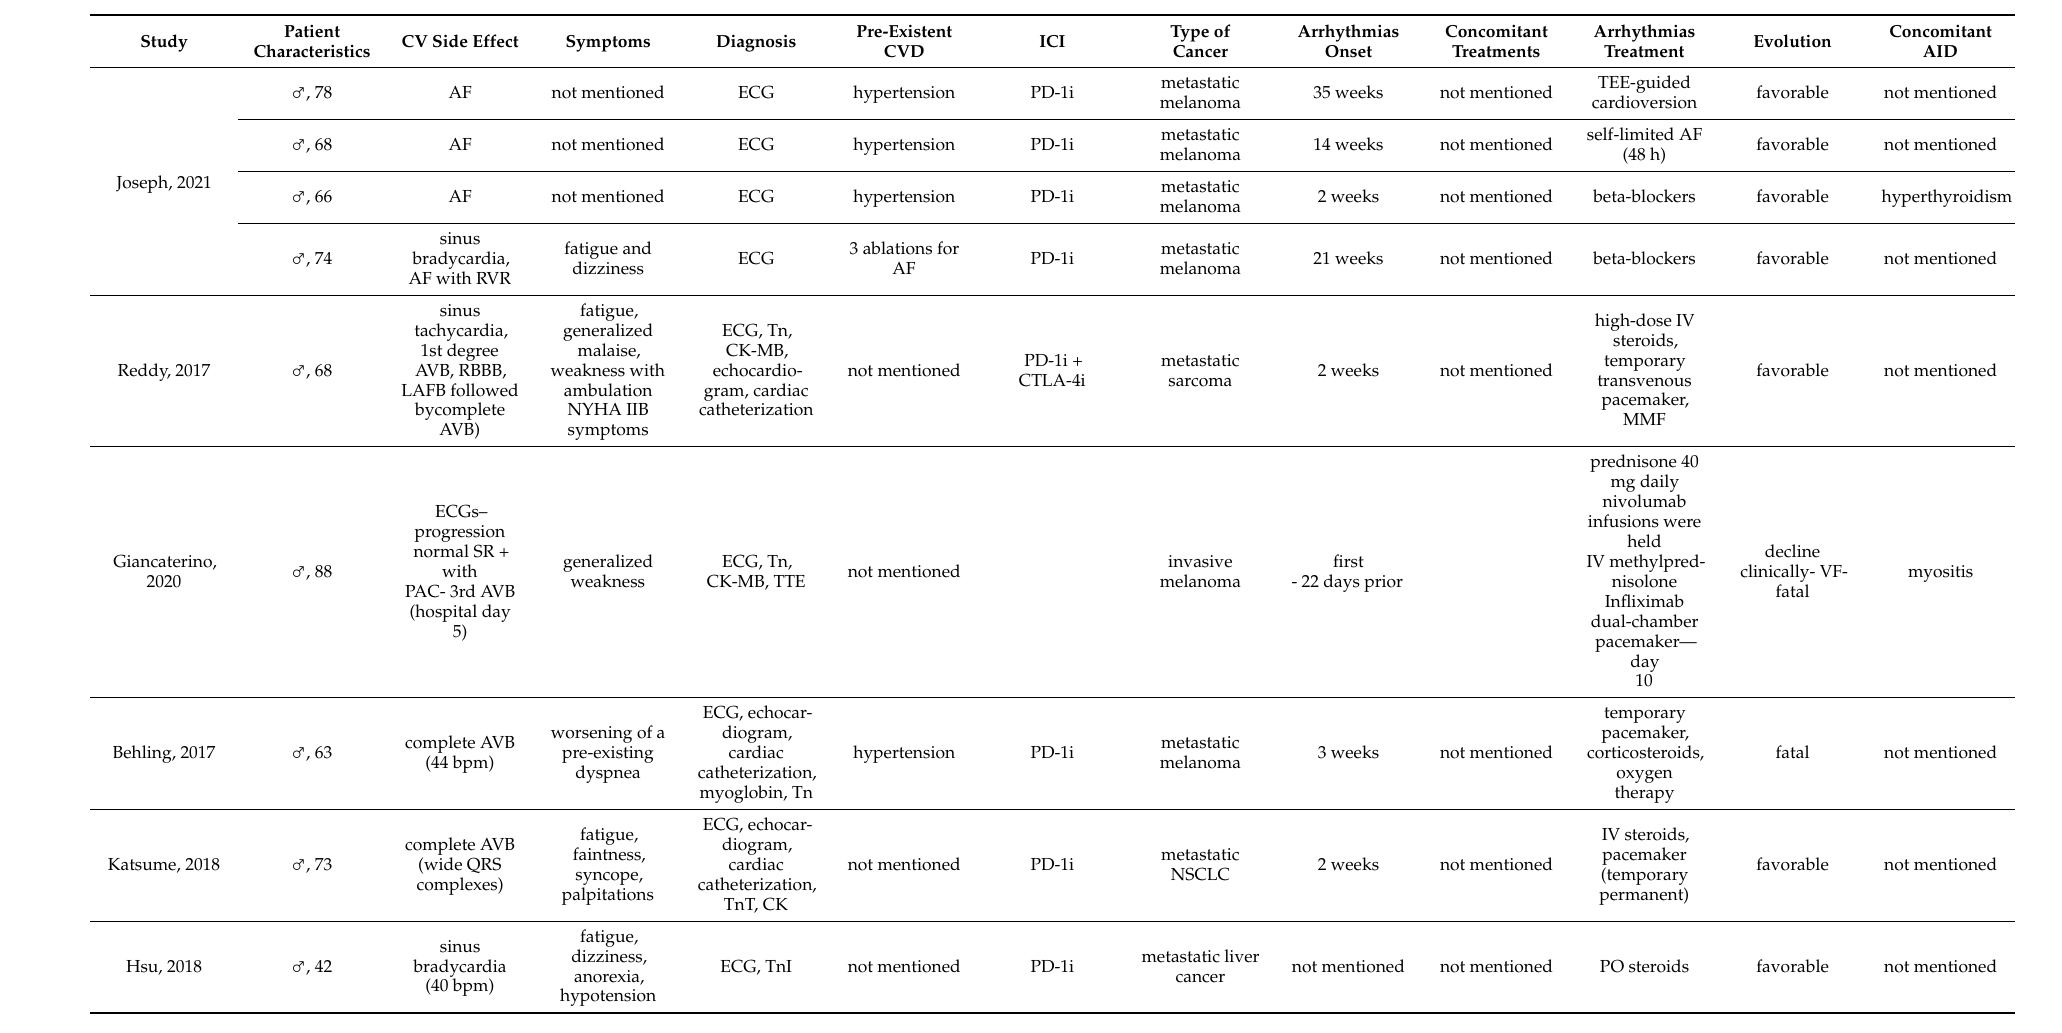
Table 3. Case reports with ICI-associated